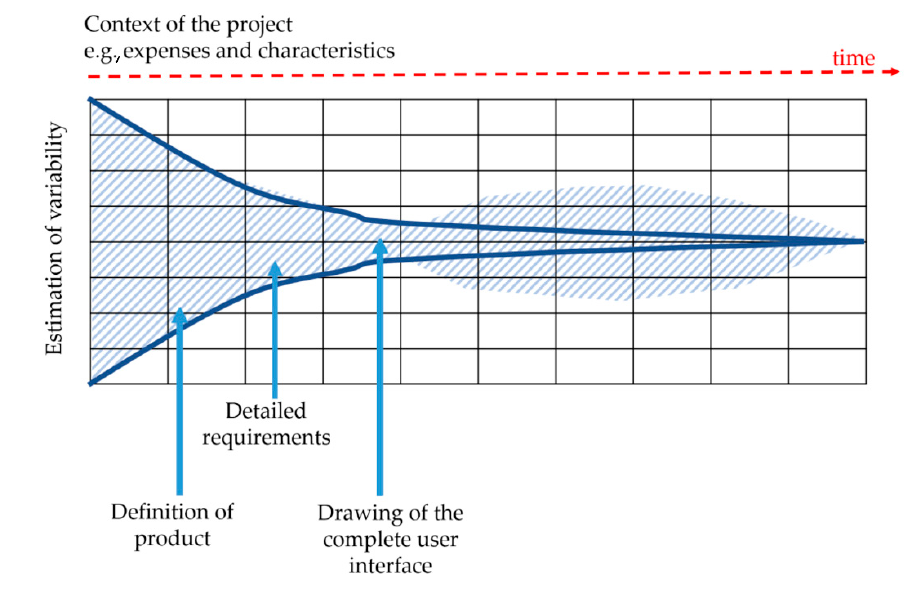
Figure 2. Uncertainty cone.